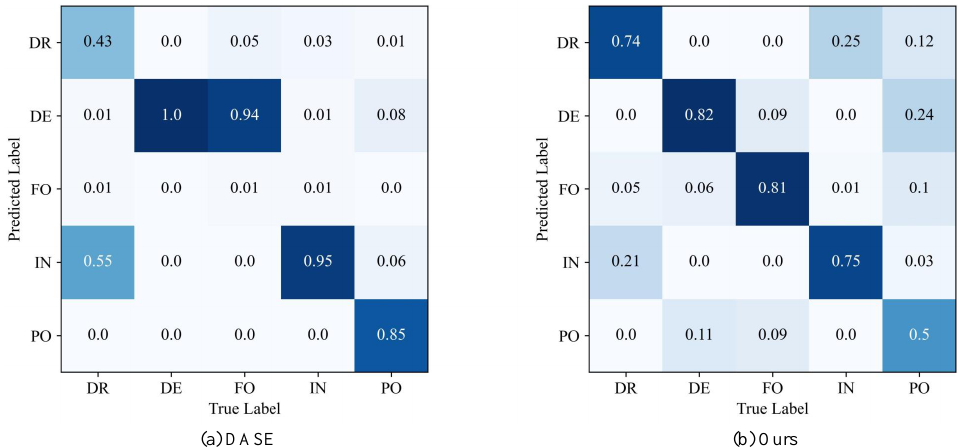
Figure 5. Confusion matrix of the two methods on the AID30 dataset. Where “DR”, “DE”, “FO”, “IN”, and “PO” denotes “dense residential”, “desert”, “forest”, “industrial”, and “pond”,